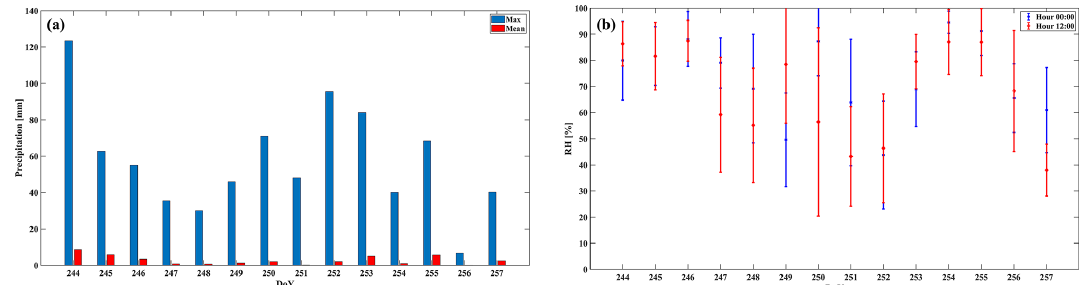
Figure 3. (a) Maximum and minimum of precipitation within the whole area and (b) relative humidity variations up to 4km height during study